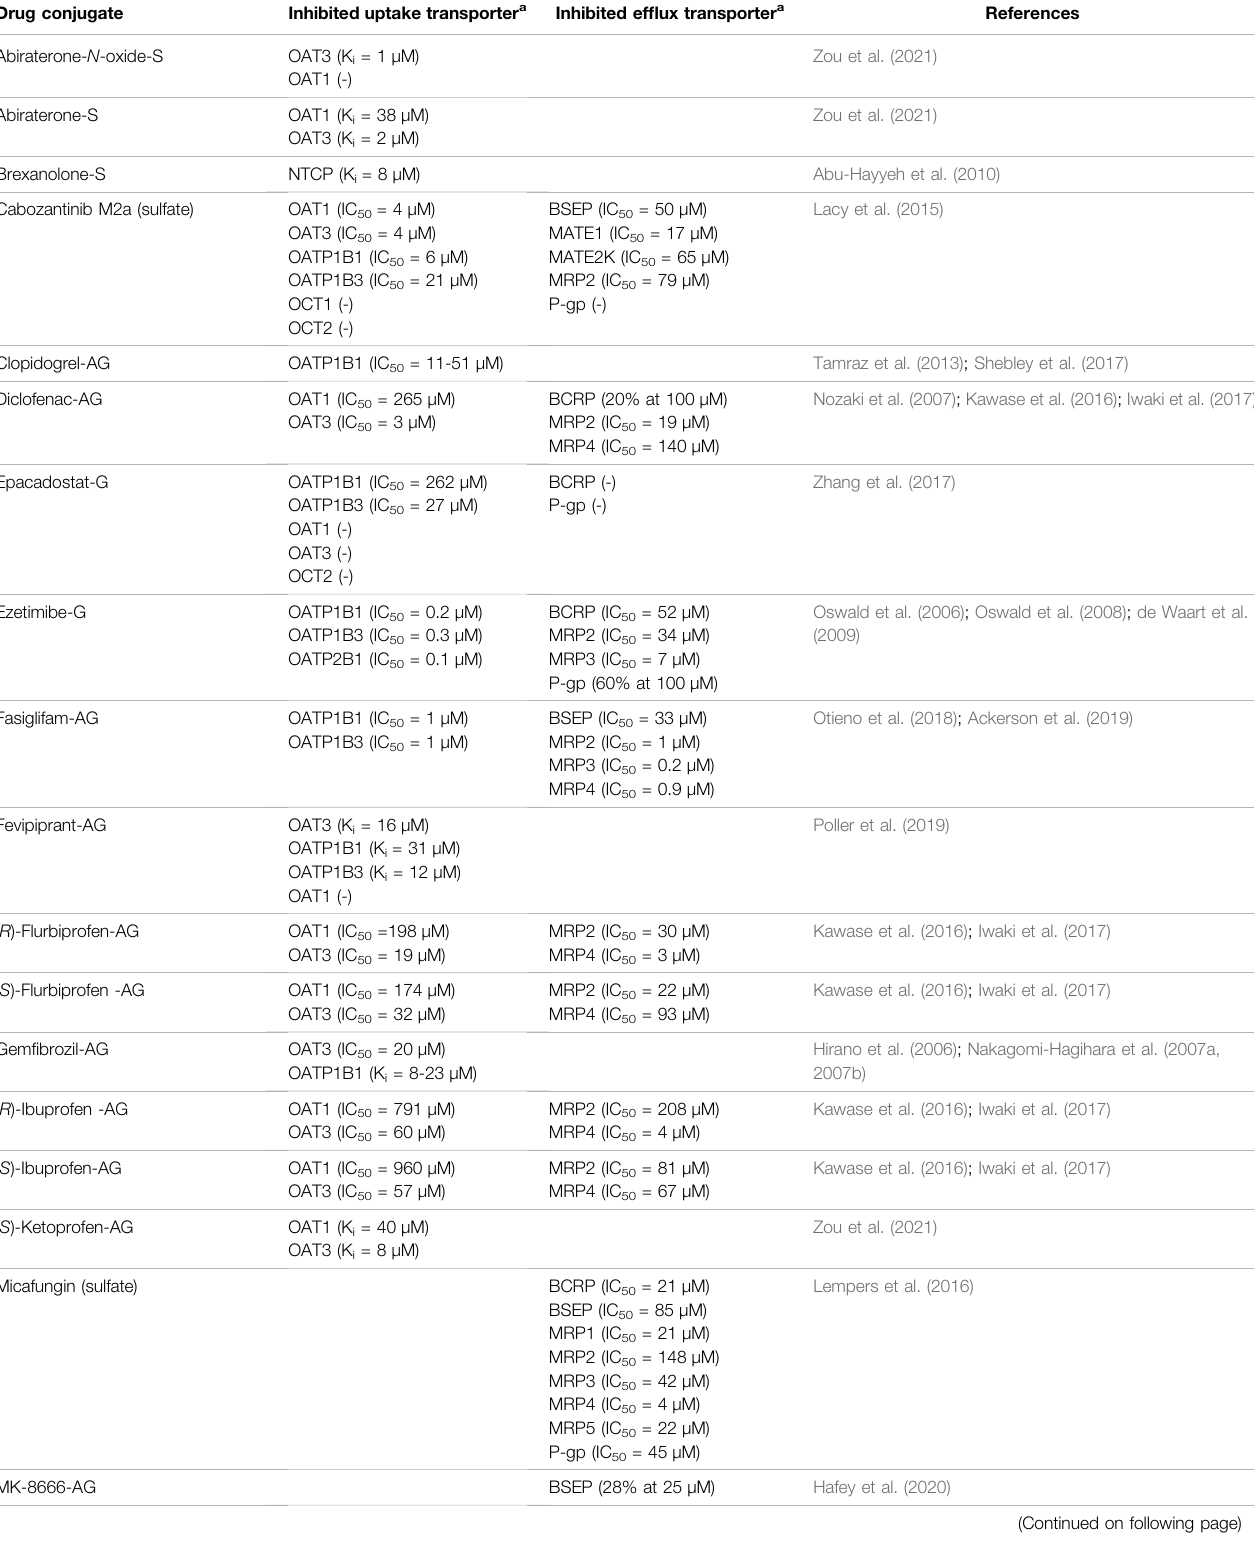
TABLE 2 | Drug glucuronides (-G and -AG) and sulfates (-S) studied as inhibitors in transporter overexpression systems. Drug